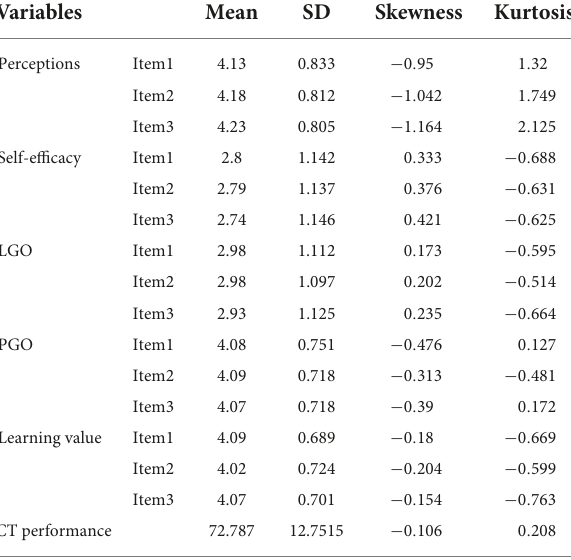
TABLE 1 Descriptive statistics.